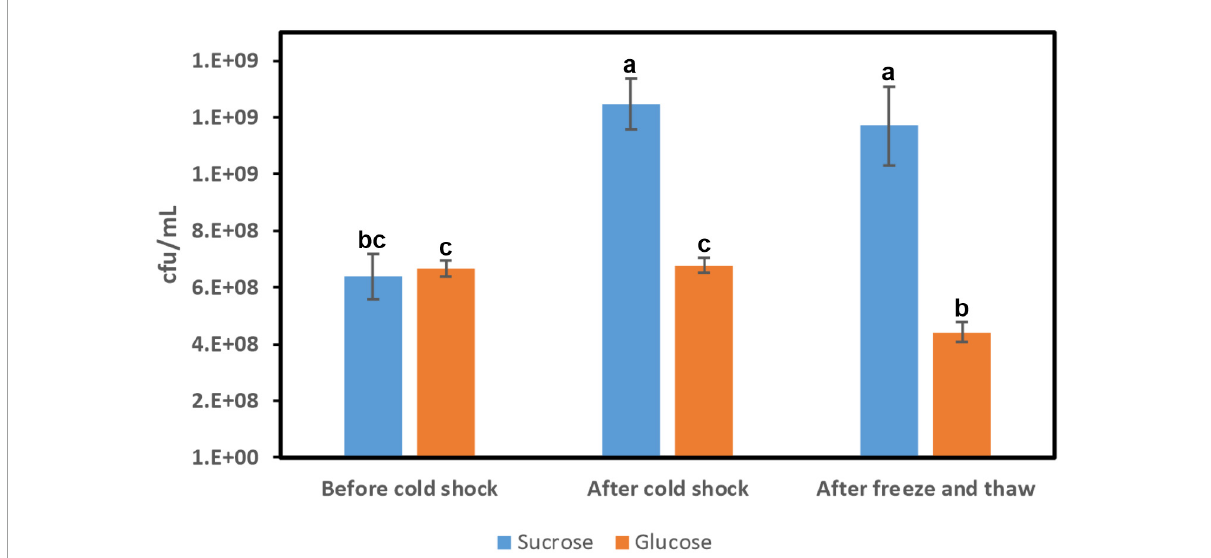
FIGURE9 Influence of cold shock in Lc. lactis AV1n[pRCR21] cell viability. Cultures were grown in MRSS or MRSG at 37 ◦ C (before cold shock), after exposure at 10 ◦ C for 18 h (after cold shock), and during 3 days frozen period at − 80 ◦ C, thawed (freeze and thaw). Cell survival was determined by plate counting at the states indicated. The means of three determinations and the standard deviations are indicated. Different superscript letters indicate that the levels differed significantly ( p = 2e − 5 ).